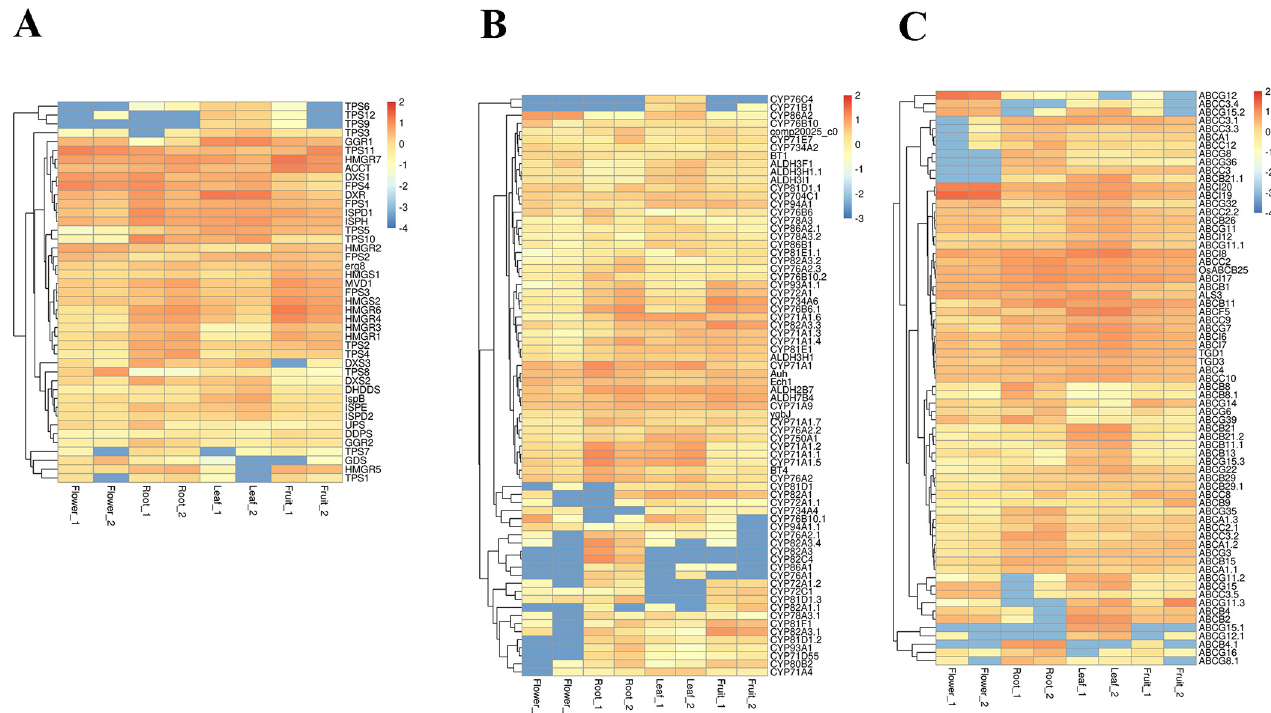
Fig 3. Hierarchical cluster analysis of DEGs involving in the monoterpenoids biosynthesis pathways in different tissues of Paeonia . (A The DEGs in terpenoid backbone and monoterpenoids biosynthesis pathway, B The DEGs in limonene and pinene degradation pathway, C The DEGs in transport